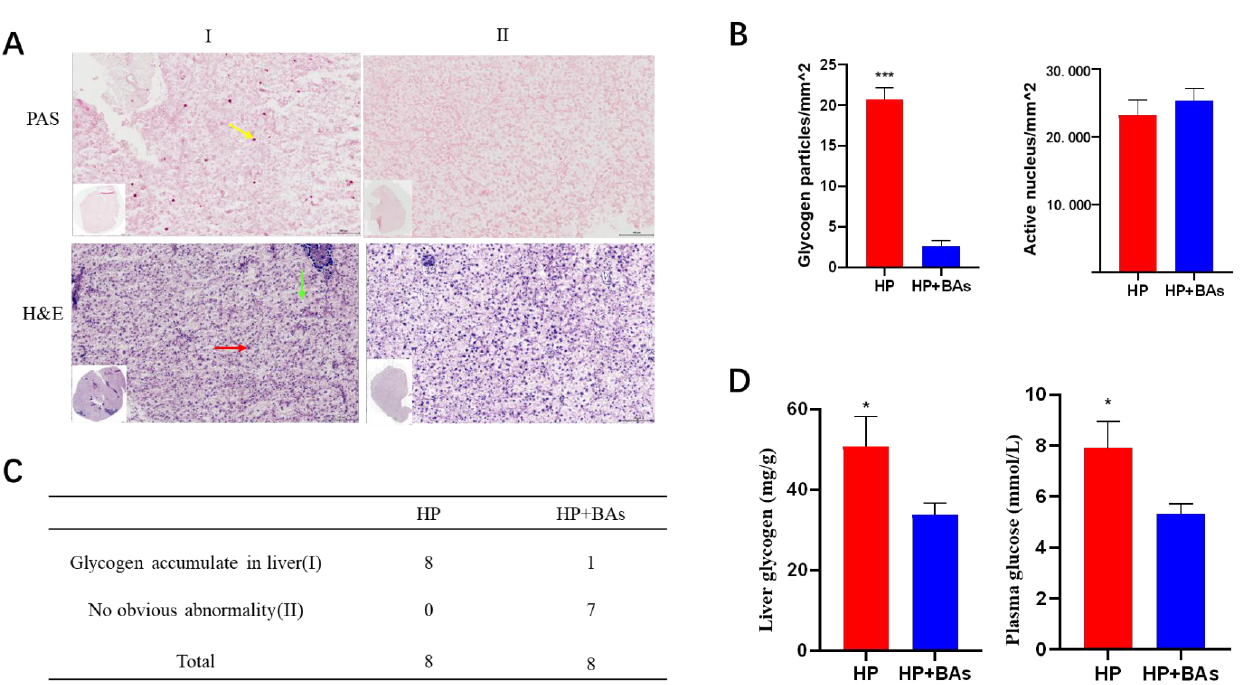
Figure 3. Supplement bile acids to high plant protein feed reduced carp hepatopancreas histological lesions (Statistically significant results were indicated by asterisks (*, p < 0.05; ***, p < 0.001)): ( A ) PAS and H&E staining of liver sections with bar = 100 μm, intracellular accumulation of glycogen (marked with yellow arrow), deformed cells (marked with green arrow) and Nuclear gathered (marked with yellow arrow) were clearly observed in the damaged hepatopancreas. ( B ) Quantification of glycogenosome and active nucleus, the number of hepatopancreas glycogenosome in the HP+BAs group carp was significantly lower than that in the HP group. ( C ) The phenotype of hepatopancreas histopathological examination in HP group and HP+BAs group. ( D ) Supplement BAs to high plant protein feed reduced hepatopancreas glycogen and plasma glucose (Statistically significant results are indicated by asterisks (*, p < 0.05; ***, p < 0.001), n = 7).